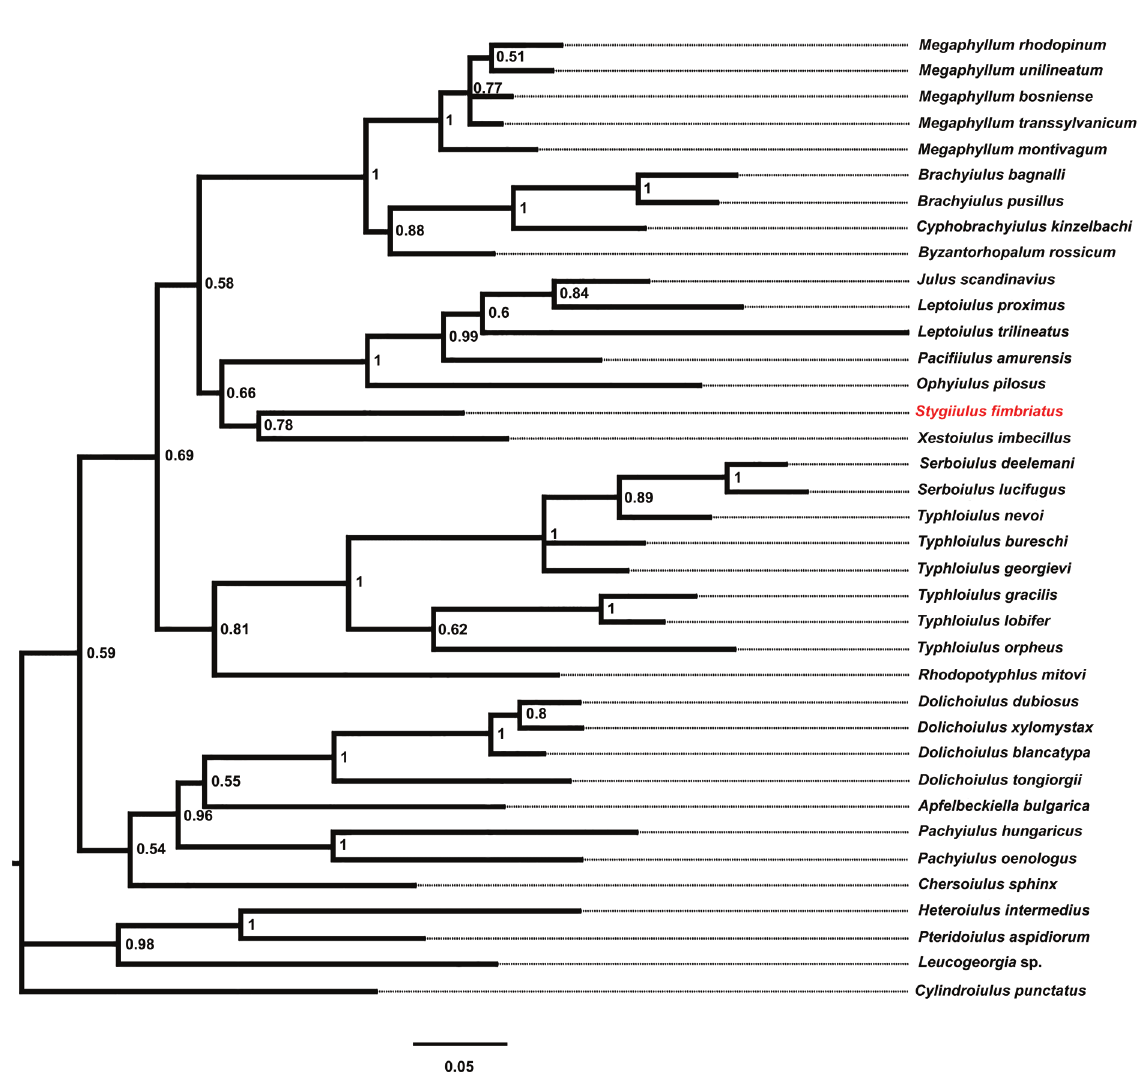
Fig. 12. Bayesian inference tree based on concatenated 16S rRNA + 28S rRNA dataset from Enghoff et al. (2013) and Makarov et al. (2017). The single species with newly obtained sequences is shown in